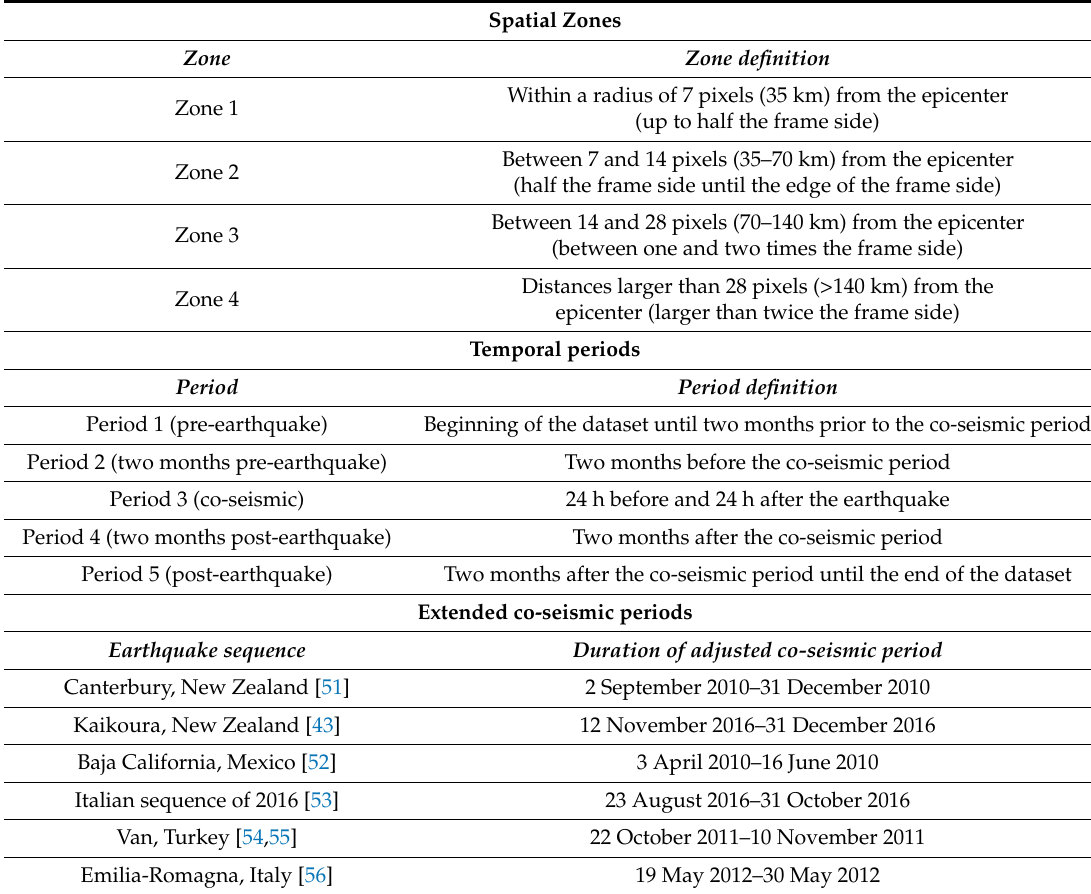
Table 2. Definitions of spatial zones, temporal periods, and adjusted co-seismic periods applied for anomaly density